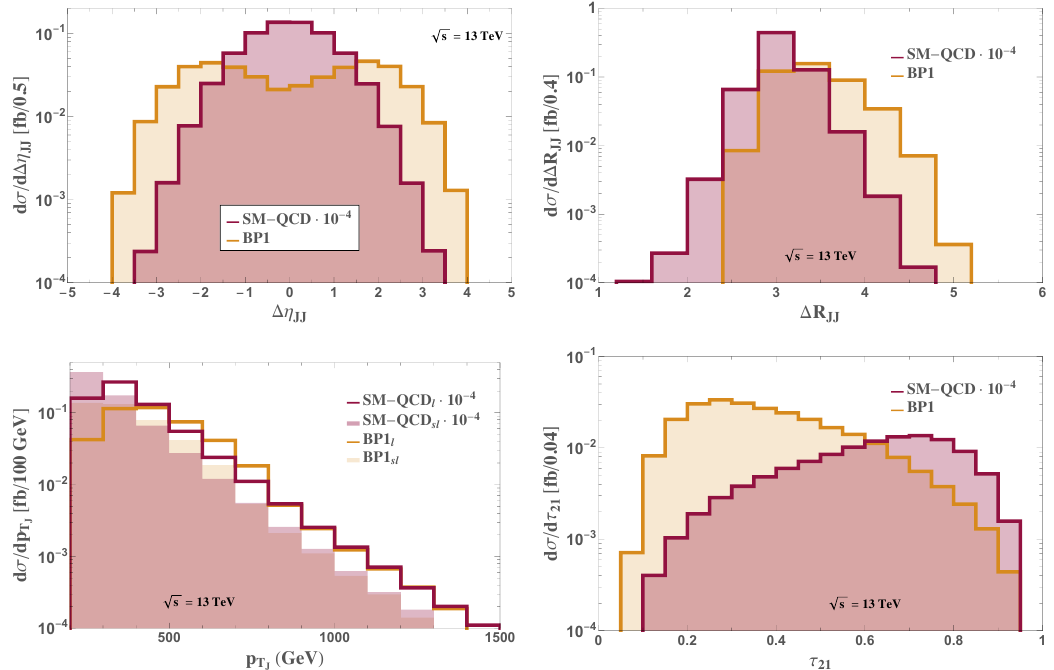
Figure 4 . Predictions, after jets reconstruction, of the cross sections distributions with the fat jet variables (cid:1) (cid:17) JJ (upper left plot), (cid:1) R JJ (upper right plot), P T plot) for the QCD background (SM-QCD, scaled down by a factor 10 scenario BP1. The cuts in eq. (3.3) and eq. (3.4) have been